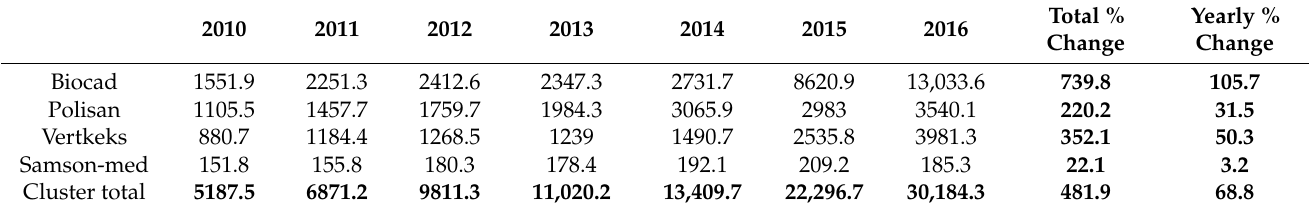
Table 3. Sales volume of St. Petersburg pharmaceutical cluster (Rub,